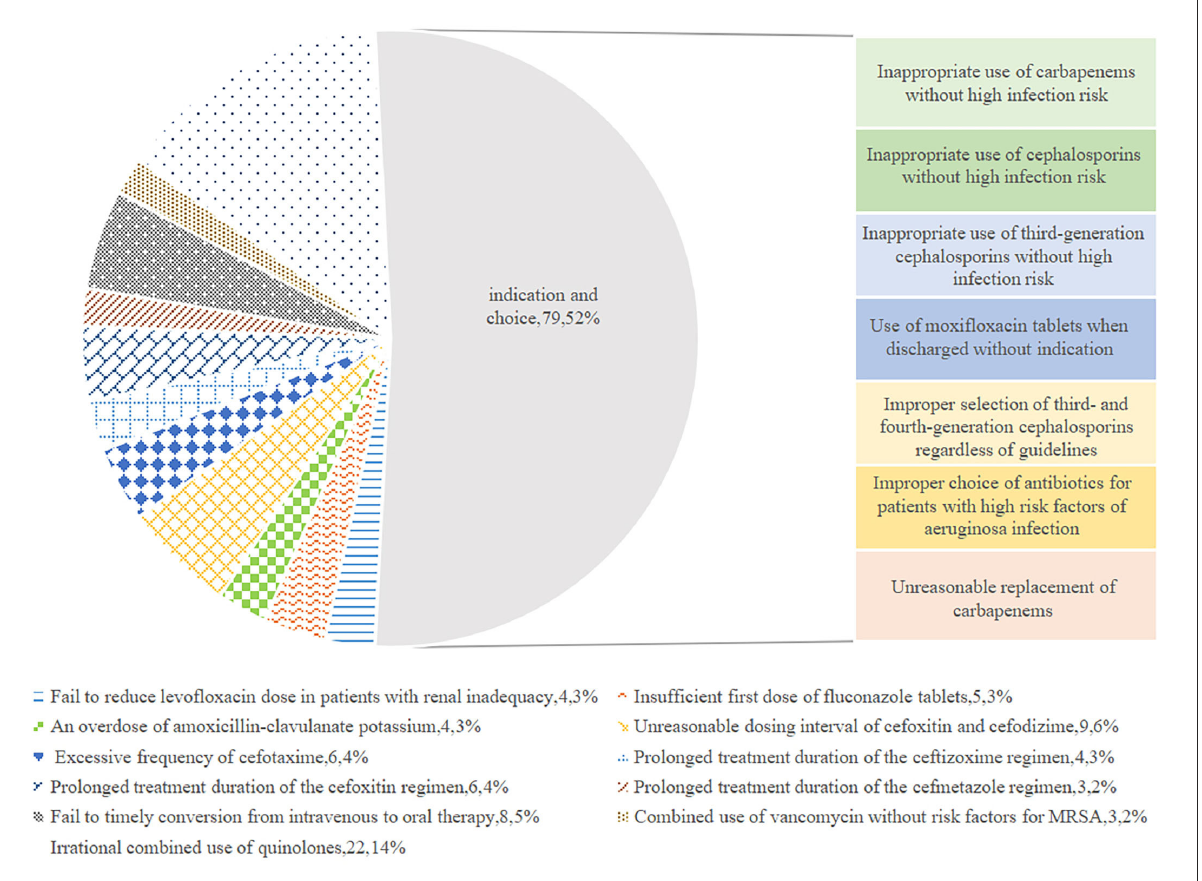
FIGURE4 Inappropriate therapeutic use of antibiotics in the respiratory